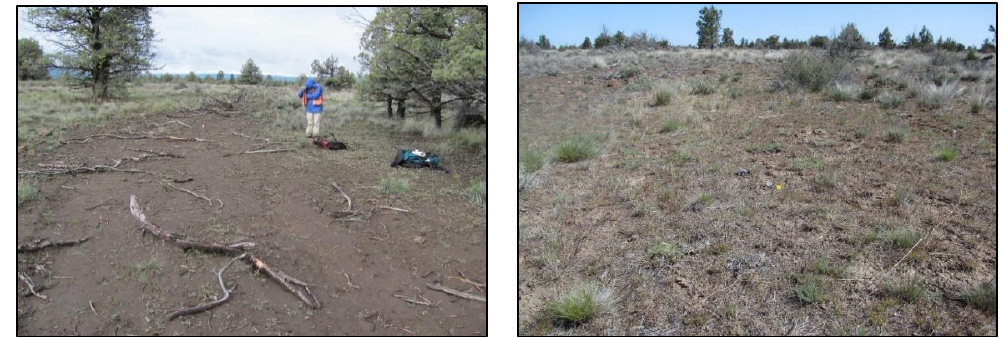
Figure 3. Skid trails shortly after juniper removal ( left ) and after several years of recovery ( right ). Due to the contract time period, some skid trails were formed at least a year before they were seeded.